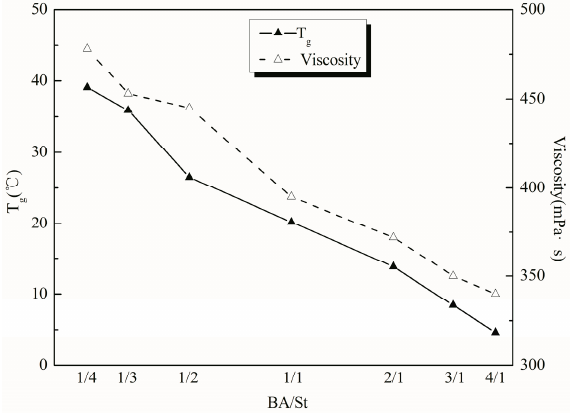
Figure 5. E ff ect of soft / hard monomer ratio on T g and viscosity. Conditions: The ratio of AA / MAA / Figure 5. Effect of soft/hard monomer ratio on T g and viscosity. Conditions: The ratio of HEMA / BMA was 1.2 / 2.6 / 35 / 40.7 in this series AA/MAA/HEMA/BMA was 1.2/2.6/35/40.7 in this series reaction.